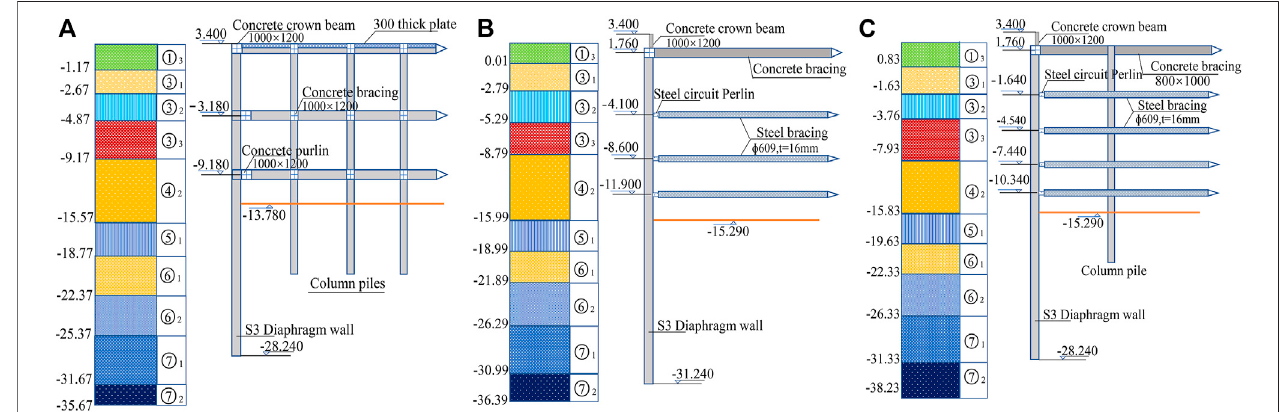
FIGURE 2 | Section of the foundation pit retaining structure. (A) 3 supports, (B) 4 supports, (C) 5 supports.